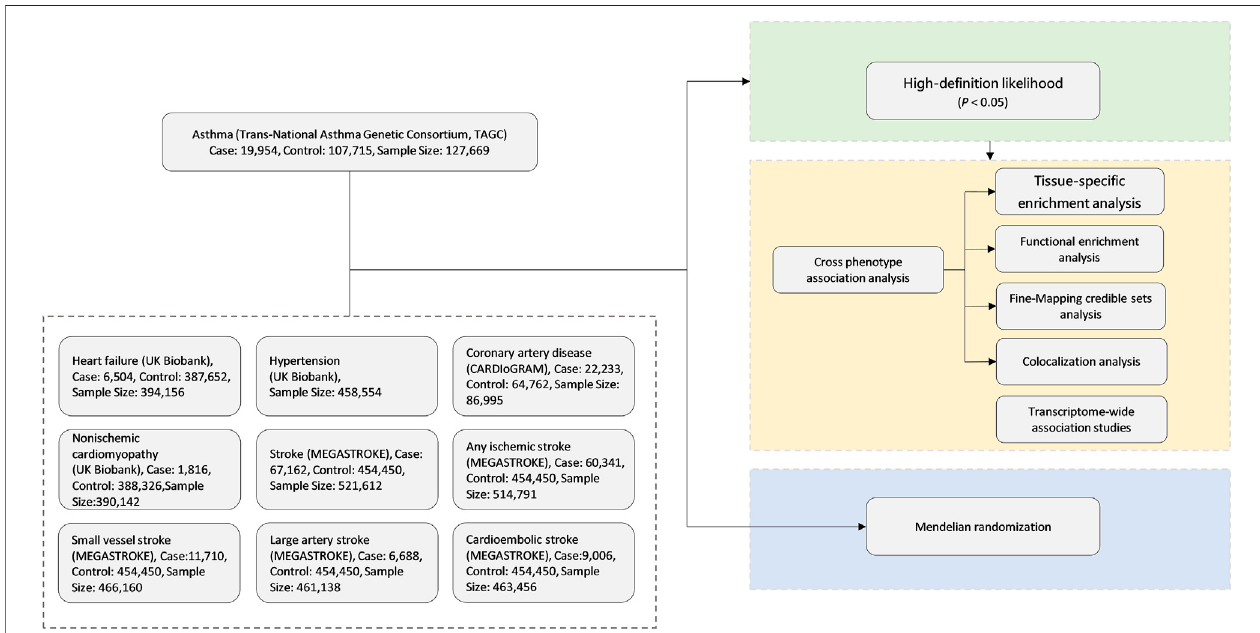
FIGURE 1 | Genome-wide cross-trait analysis study design. CARDIoGRAM, Coronary ARtery Disease Genome-Wide Replication And Meta-Analysis; MEGASTROKE, multi-ancestry genome-wide association study of 520,000 subjects identi fi es 32 loci associated with stroke and stroke subtypes.